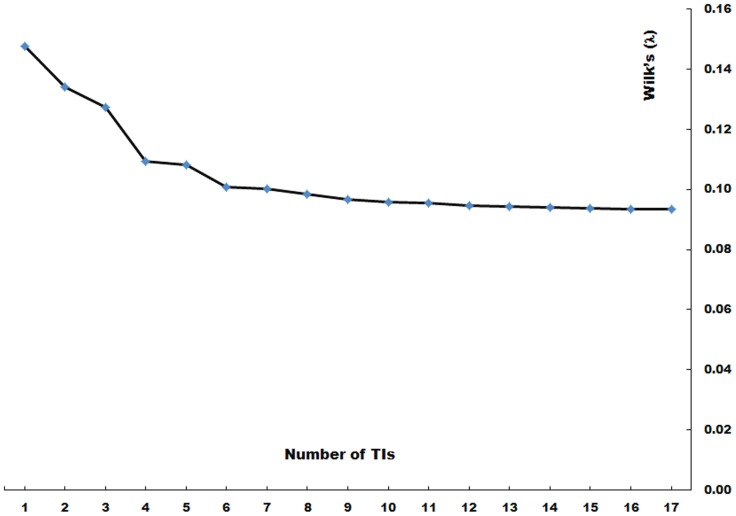
Assessing the relationship between the number of TIs entered in each model and the Wilk's (λ) values obtained for each one.